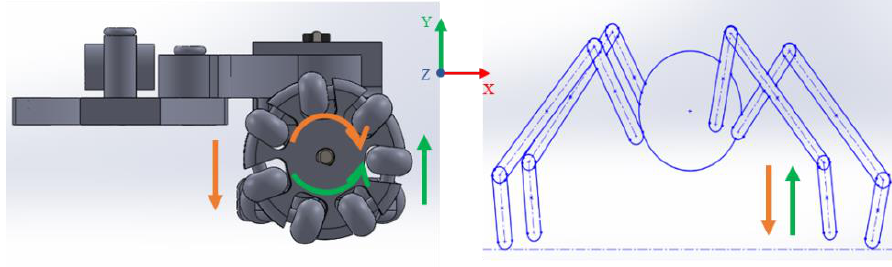
Figure 2. Robot movements are imitating a spider in the y -axis direction.